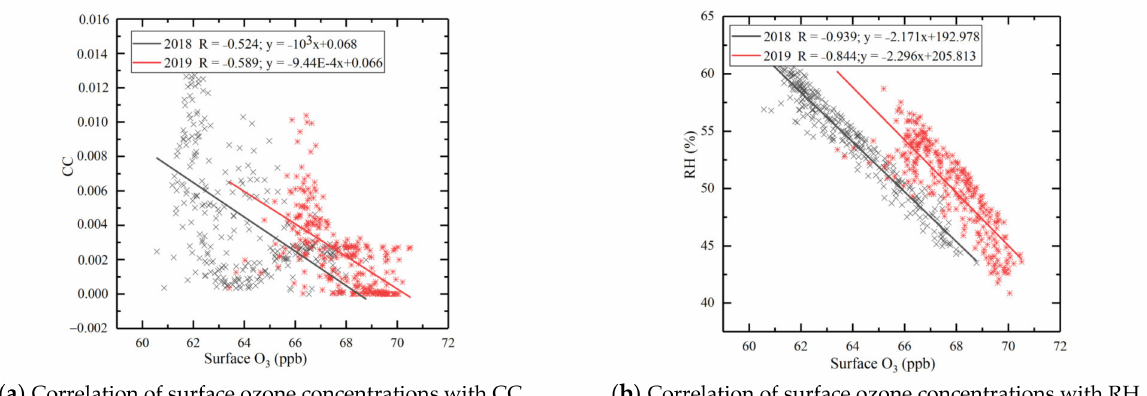
Figure 17. Correlation of surface ozone concentrations with CC ( a ) and RH ( b ) in northern YRD (32 ◦ –34 ◦ N, 116 ◦ –119 ◦ E) from 2018 to